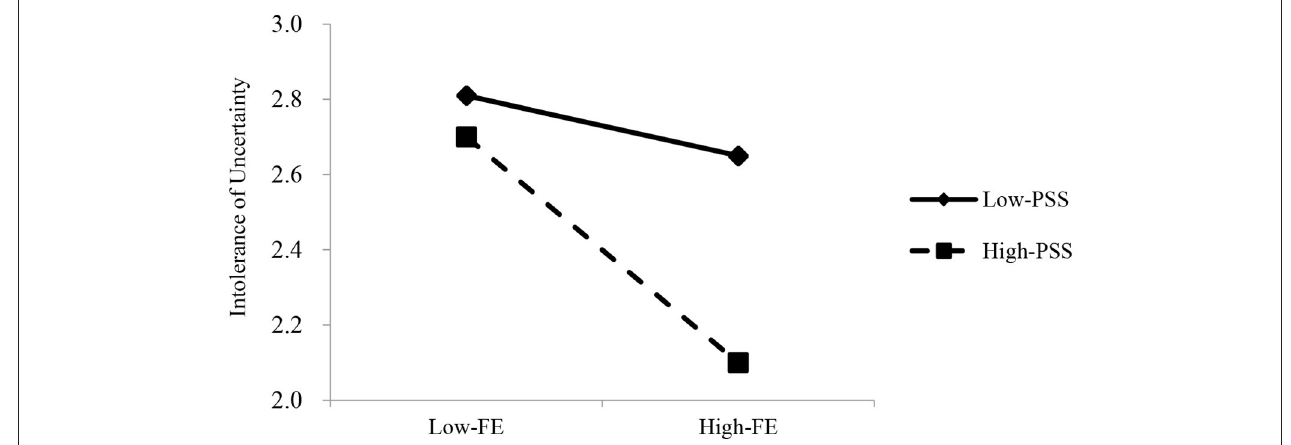
FIGURE 4 | The moderating effect of perceived social support between future expectations and intolerance of